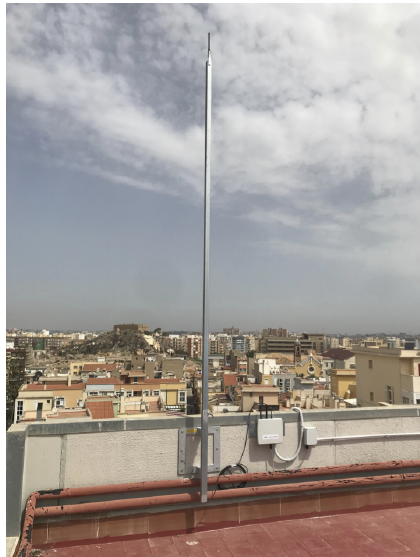
Figure 7. TM RG186 series LoRa-enabled gateway (Universidad Politecnica de Cartagena, Spain).